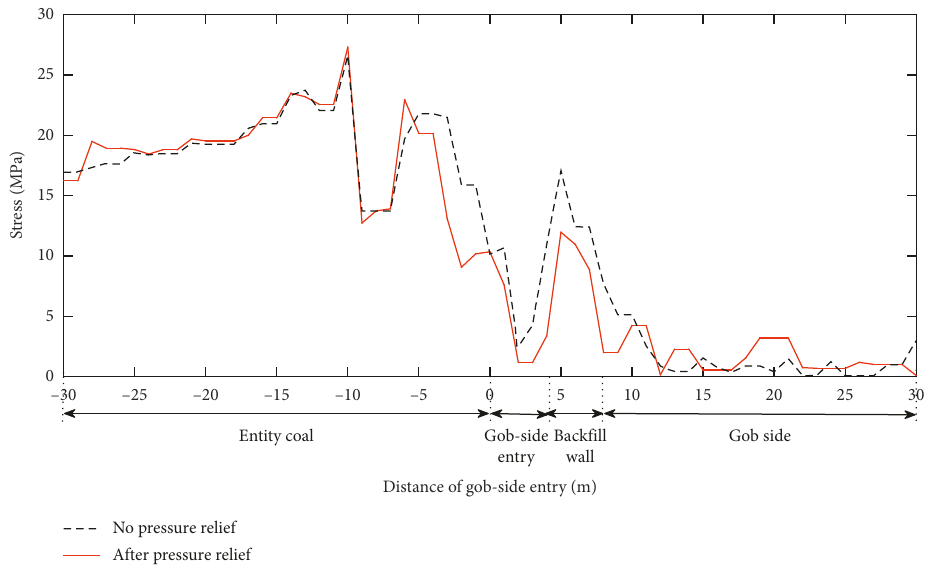
Figure 12: Stress distribution and its variations of roof cutting and non-roof-cutting.